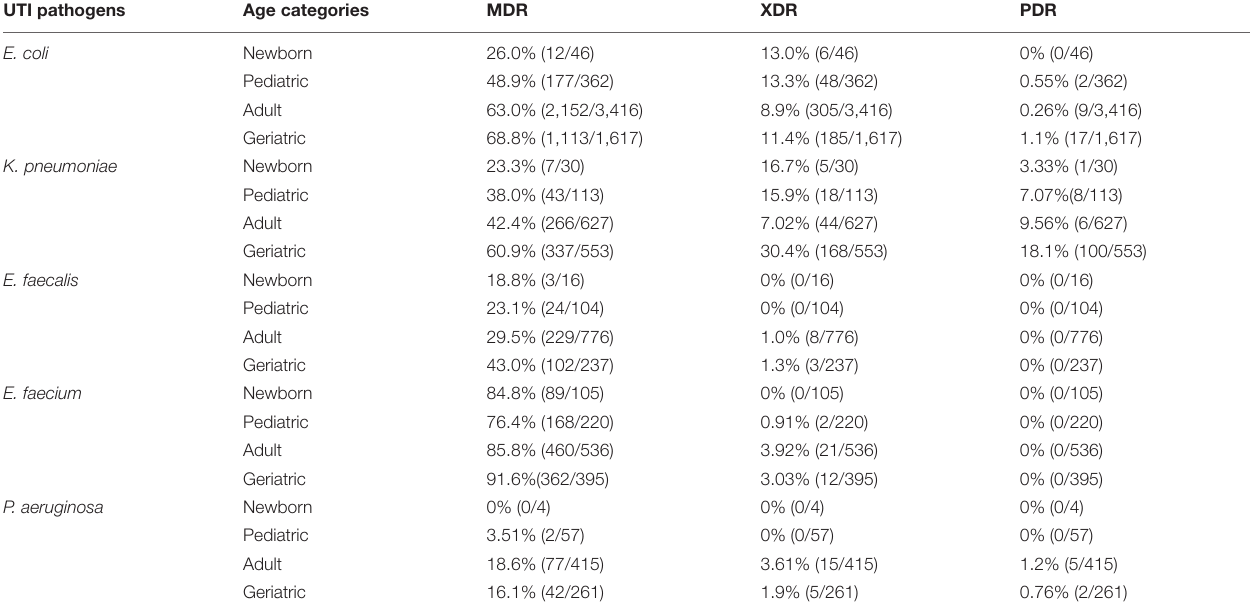
TABLE 3 | Occurrence of MDR, XDR, and PDR among the top 5 UTI pathogens. UTI